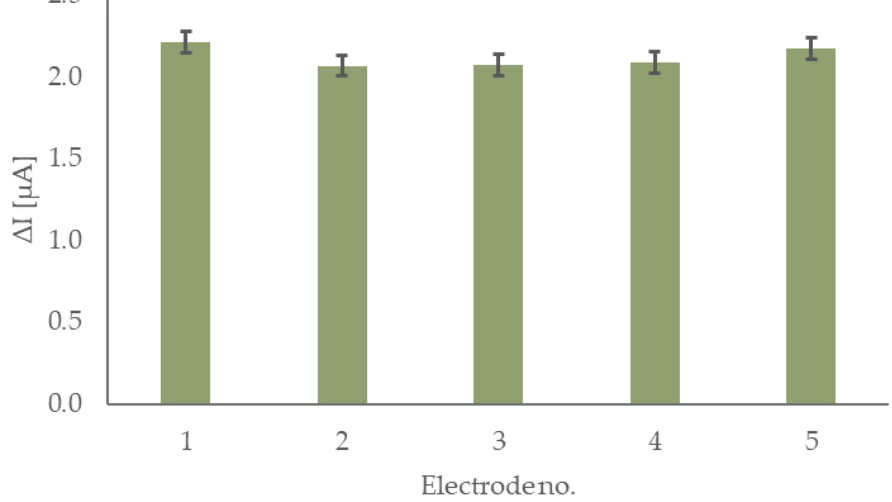
Figure 6. Responses of the sensor for five individually prepared electrodes.